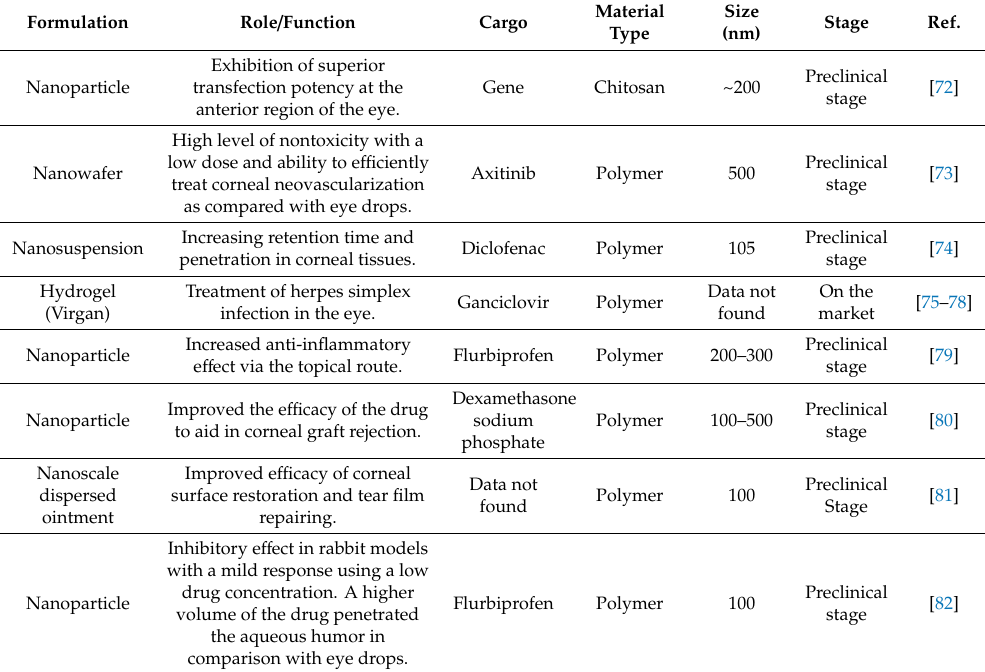
Table 1. The current and traditional strategies based on nanotechnology used in the therapy of anterior glaucoma